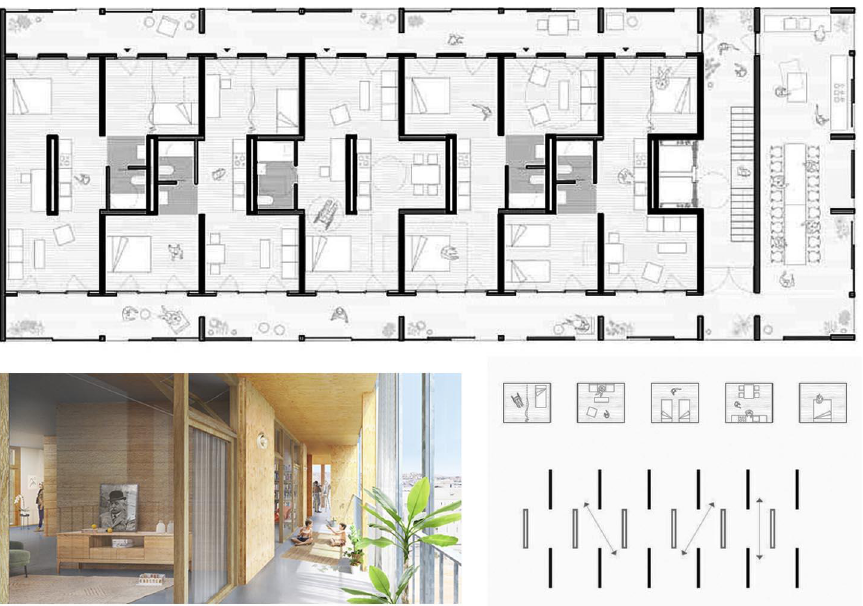
Figure 9. La Regadora by Arqbag and Poma Arquitectura. Top: typical plan showing dwellings to the left of the circulation core and common areas to the right. Below left: View from the entrance corridor. Below right: Structural diagram, an alignment of structural and spatial organization allows maximum flexibility in use and adaptation. Source: courtesy of Arqbag and Poma Arquitectura.